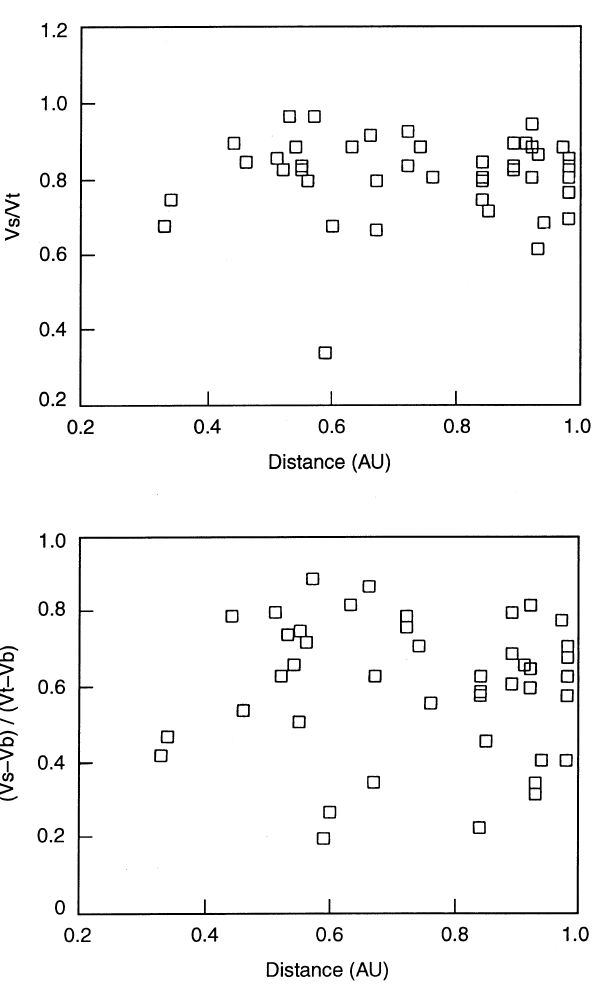
Fig. 2. Local-shock-speed dependence of the Vs = Vt ( upper panel ) and (cid:133) Vs (cid:255) Vb (cid:134) = (cid:133) Vt (cid:255) Vb (cid:134) ( lower panel ).